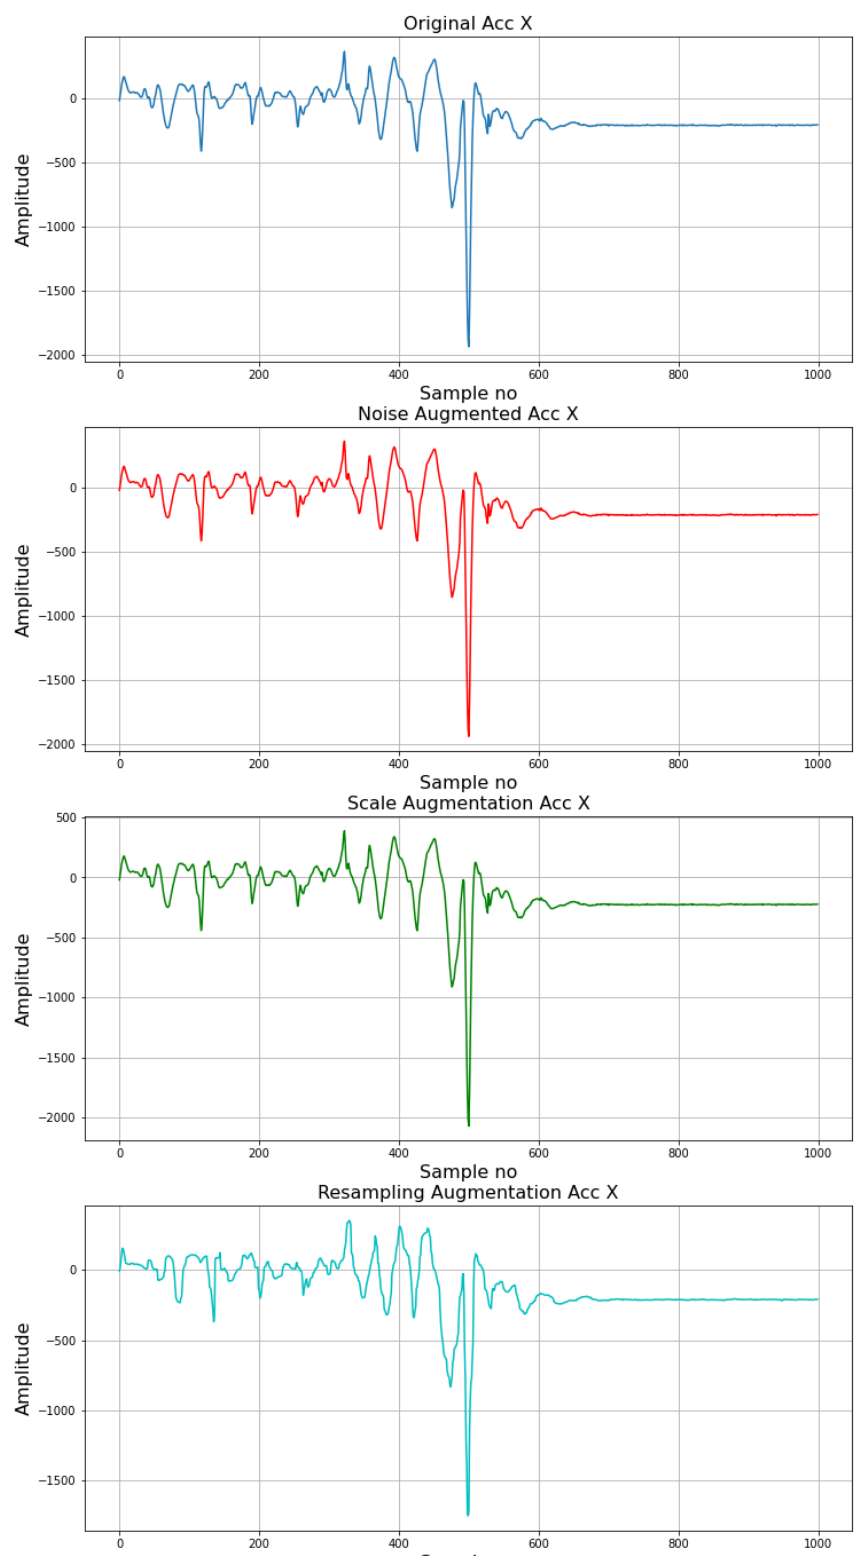
Figure 2. Illustration of data augmentation. (X component of the accelerometer, lateral